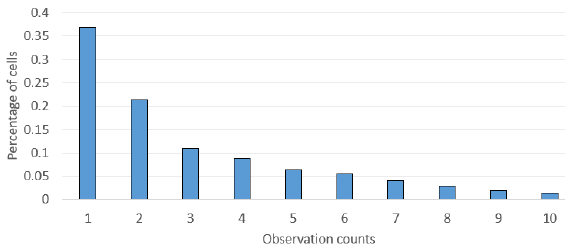
Figure 12. Proportion of the cells according to the count of stored